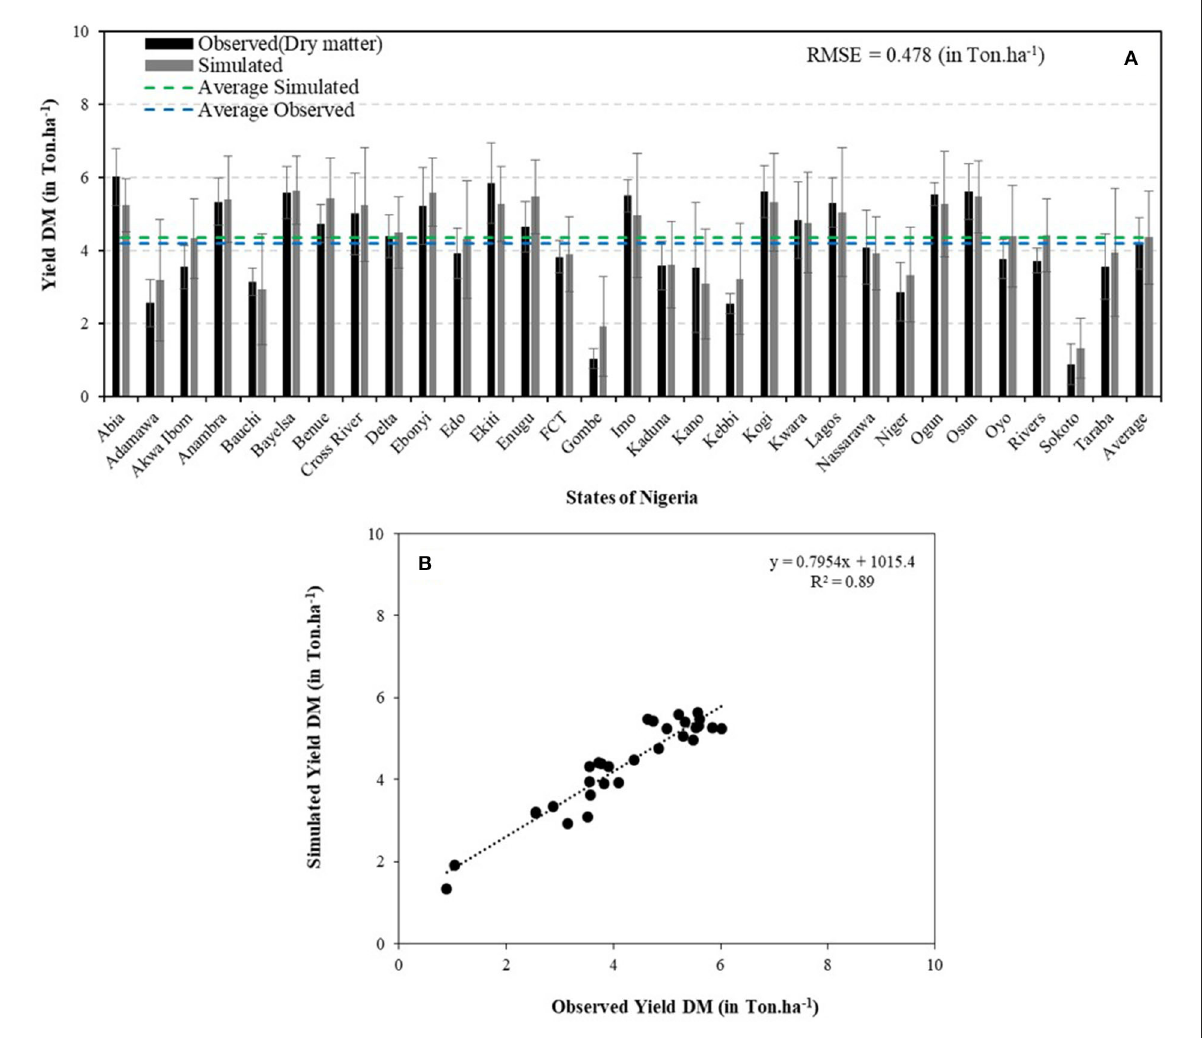
FIGURE3 Simulated actual yield (nutrient and water-limited) vs. observed (farmer’s yield at the state level in Nigeria) cassava dry matter yield (in Ton.ha − 1 ) averaged per state over 20 years from 1995 to 2014 (A) and regression line across the 30 states (B) in